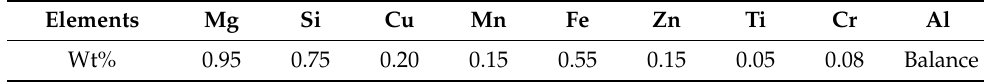
Table 1. Composition of 6061Al alloy (mass